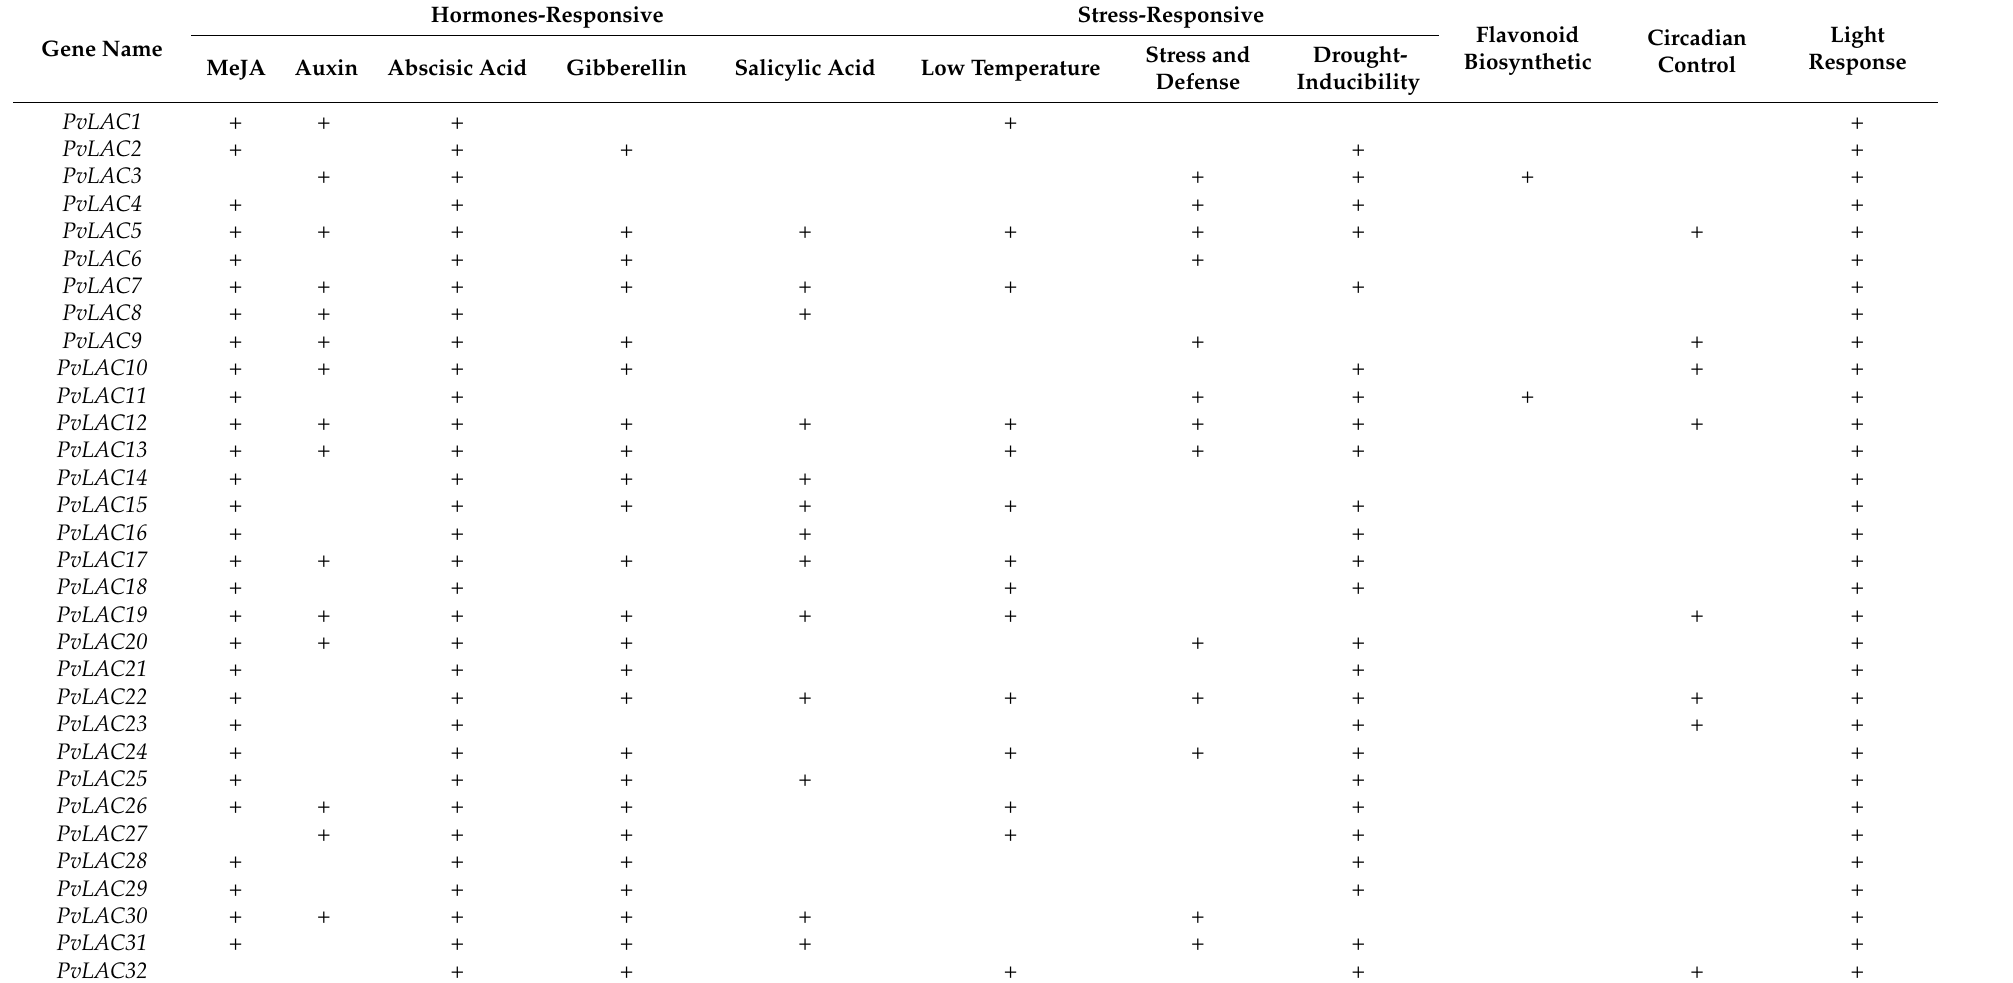
Table 2. The cis -element analysis of PvLAC promoters. MeJA, methyl jasmonate. The plus signs indicate the existence of a corresponding element. The detailed cis -element information is shown in Figure